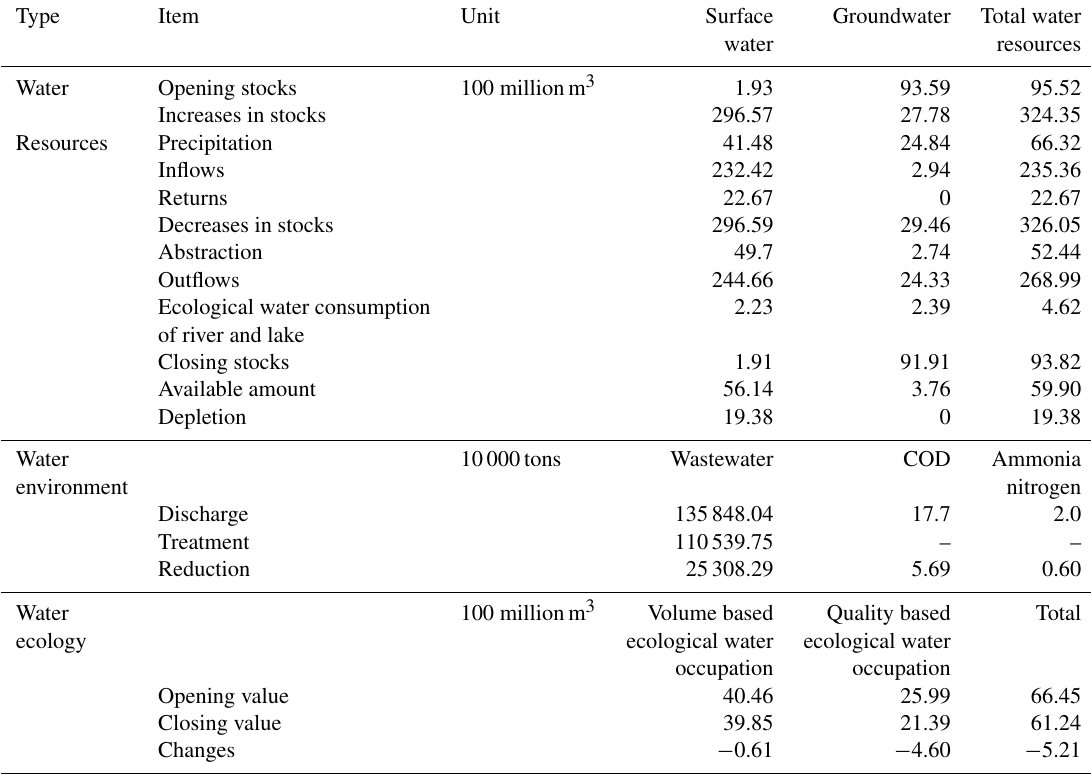
Table 1. The physical accounts of water resources assets in Chengdu.